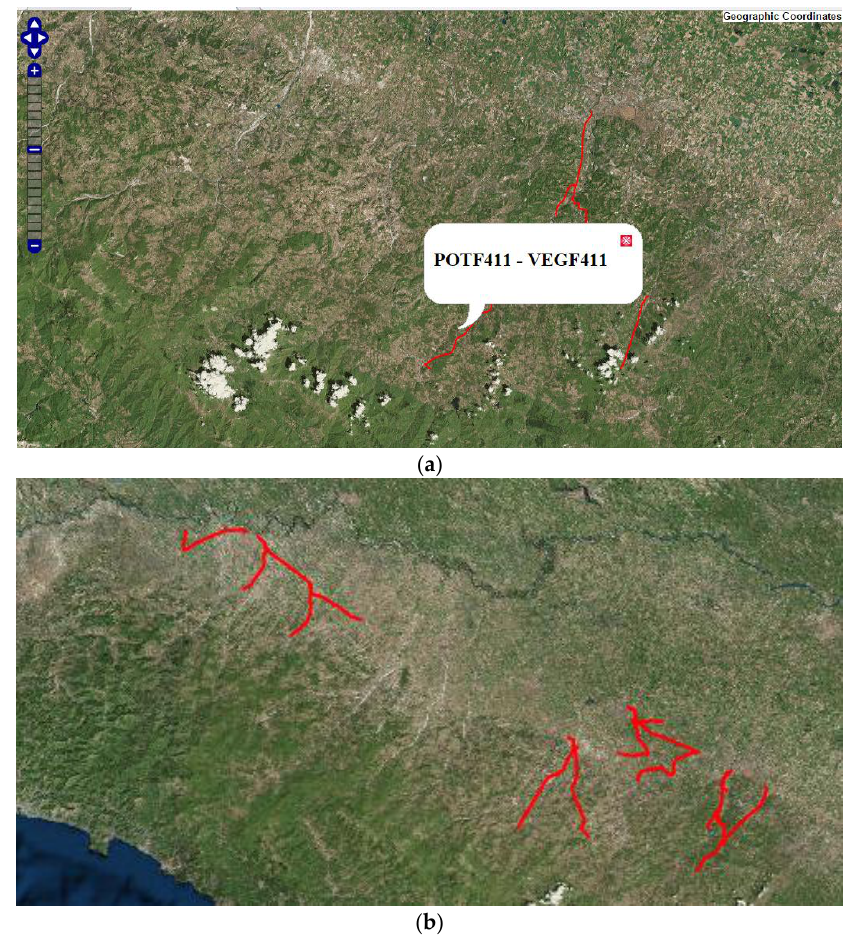
Figure 6. Geographical localization of the critical lines for ( a ) hour 15 and ( b ) hour 28.